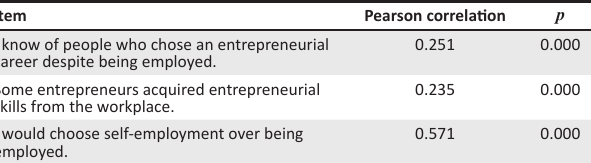
TABLE 11: Correlation between employment and entrepreneurial intentions. Item Pearson